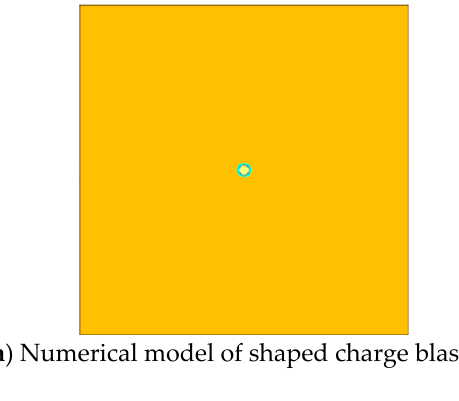
Figure 16. Blasting numerical model.